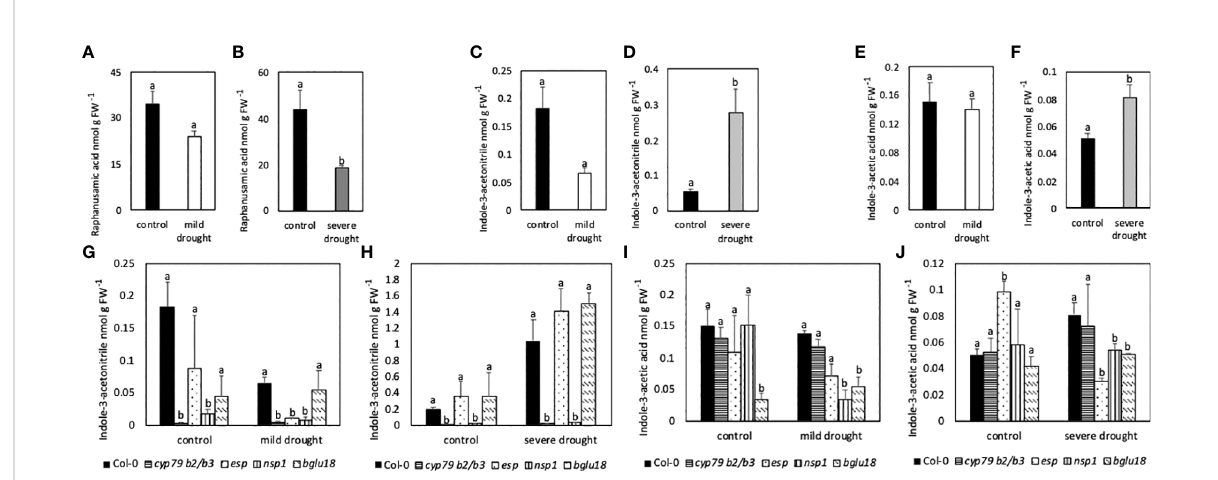
FIGURE 8 Contents of raphanusamic acid (RA; A, B ), indole-3-acetonitrile (IAN; C, D, G, H ) and indole-3-acetic acid (IAA, E, F, I, J ) in leaves of mildly and severely drought-stressed Arabidopsis thaliana Col-0 plants and cyp79B2/B3 and nsp1 mutants subjected to 20% and 40% PEG 20,000 for seven days. Plants were grown on petri dishes for fi ve weeks prior to application of drought stress. Bars represent means of three biological replicates consisting of four pooled plants each. Different letters indicate signi fi cant differences (p<0.05) between control and drought-stressed plants (A – F) and between Col-0 and mutants (G – J)